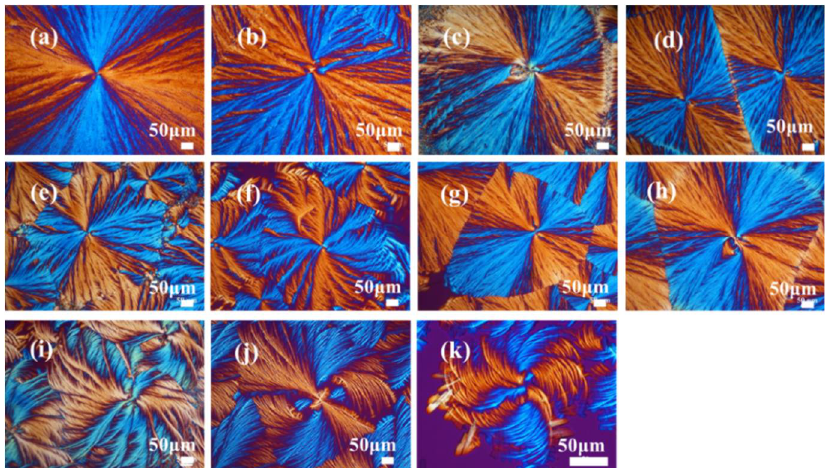
Figure 2. POM graphs of (R)-MA/PVPh (50/50) blend at different T c : ( a ) 30, ( b ) 35, ( c ) 36, ( d ) 40, ( e ) 45, ( f ) 48, ( g ) 50, ( h ) 55, ( i ) 60, ( j ) 63, and ( k ) 65 °C.